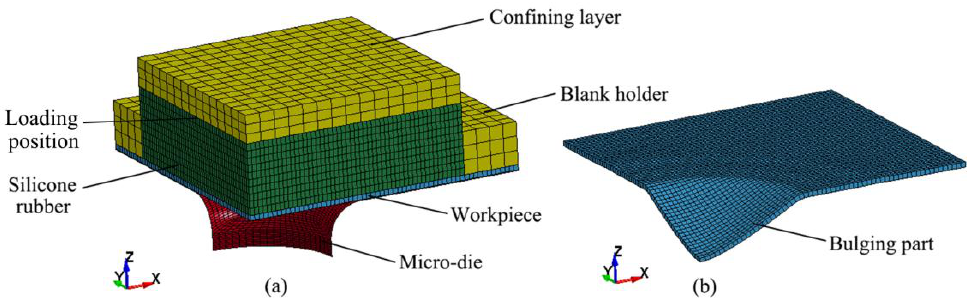
Figure 4. ( a ) The 1/4 finite element model of laser flexible shock micro-bulging; ( b ) micro bulging part.